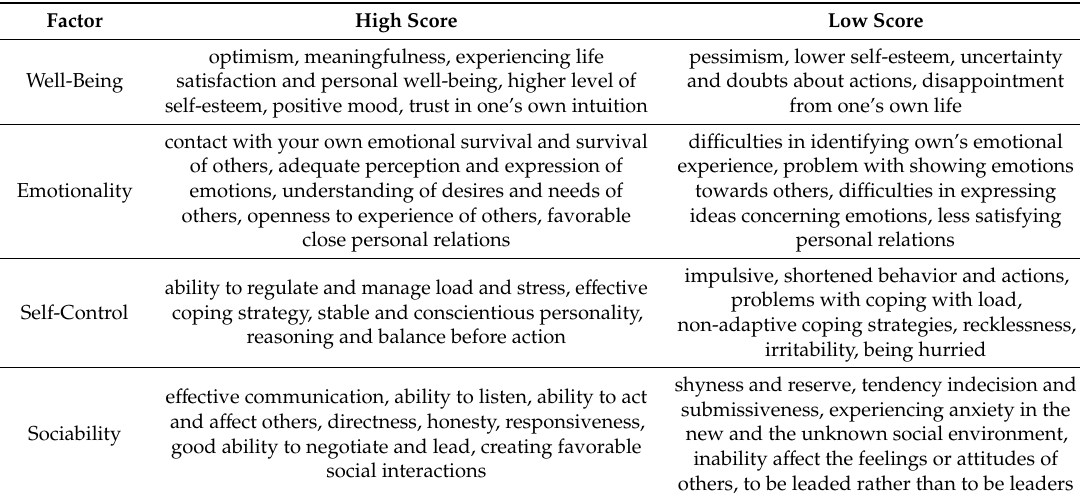
Table 3. Interpretation of high and low scores in the TEIQue SF questionnaire.